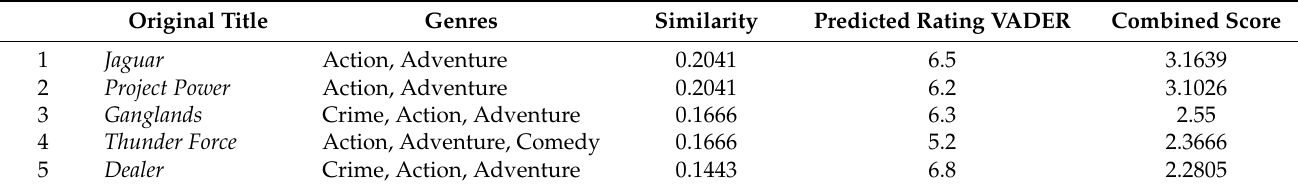
Table 11. Similar movies to the movie The Lord of the Rings: The Return of the King